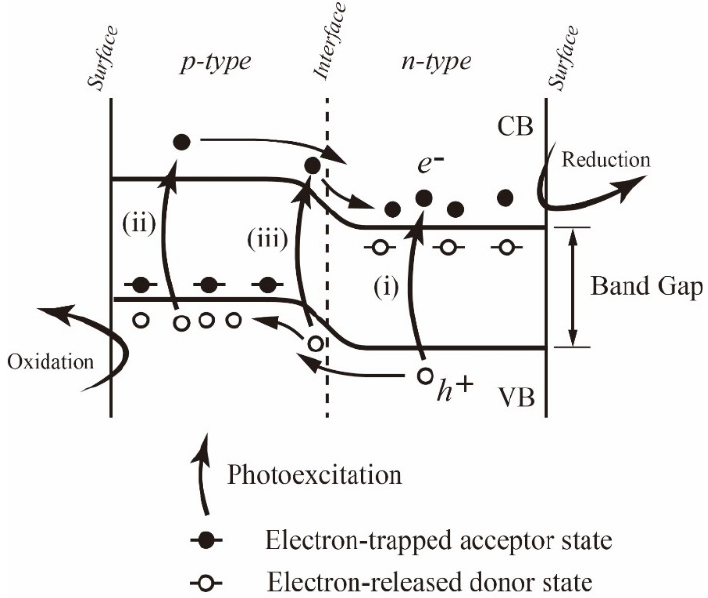
Figure 2. Schematic illustration of photocatalysis mechanism of a heterostructure using p- and n-type semiconductors under light illumination above band-gap energy. The potential slope at the interface between p- and n-type semiconductors can effectively separate generated electron-hole ( e − – h + ) pairs. VB: valence band, CB, conduction band. (See the main text about ( i )–( iii )).